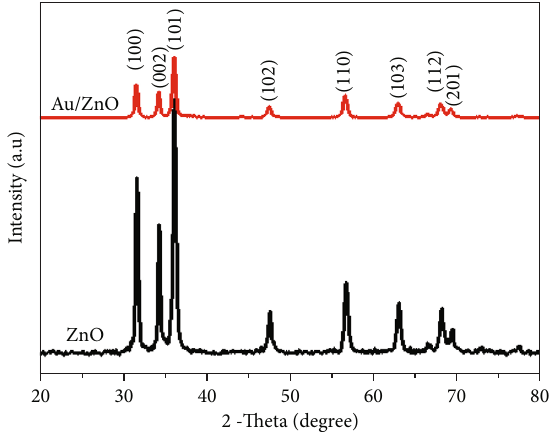
Figure 5: XRD patterns of bare ZnO and Au/ZnO-5 composite.